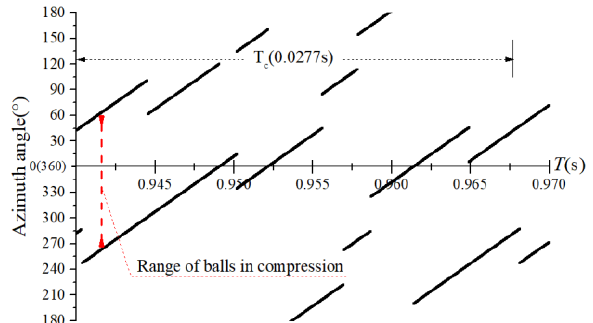
Figure 24. Time-domain diagram of the load region ( f ce = 8 N).